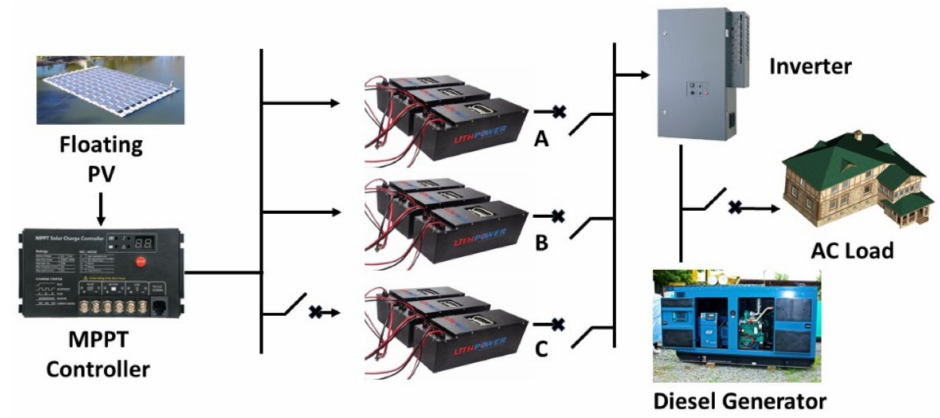
Figure 12. Schematic of a FPV/Diesel hybrid system [78].